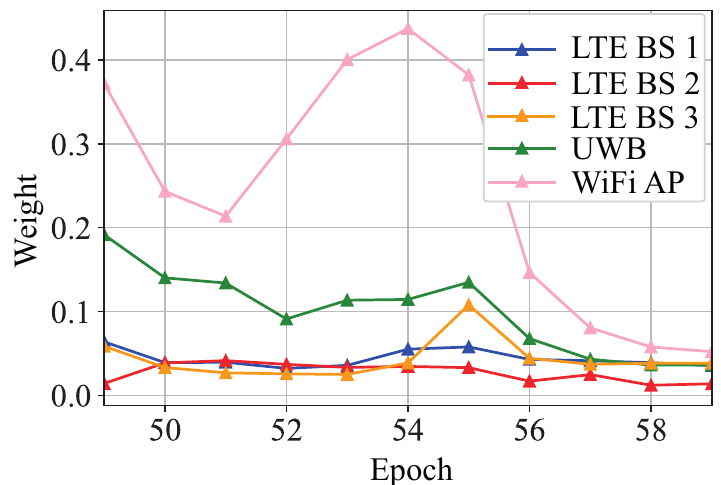
Figure 2. Functionality of the MLE during a real